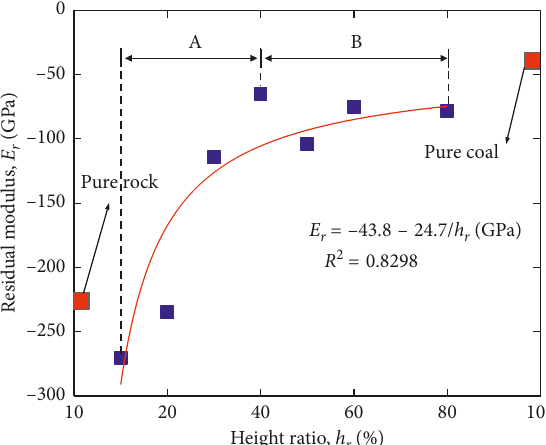
Figure 12: Relation between height ratio and the postpeak